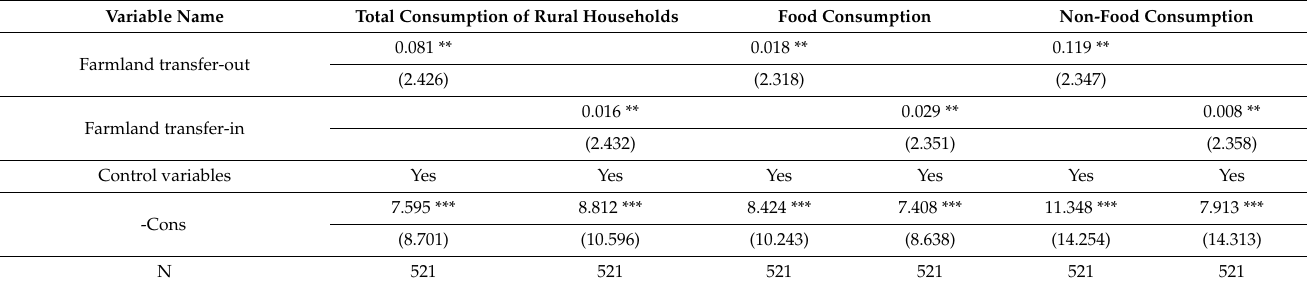
Table 4. Robustness test I: Sub-sample test.